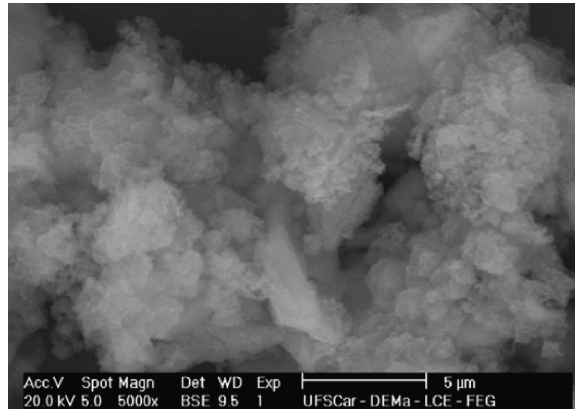
Figure 3: SEM C-S-H gel morphology of bamboo leaves’ ashes [25].